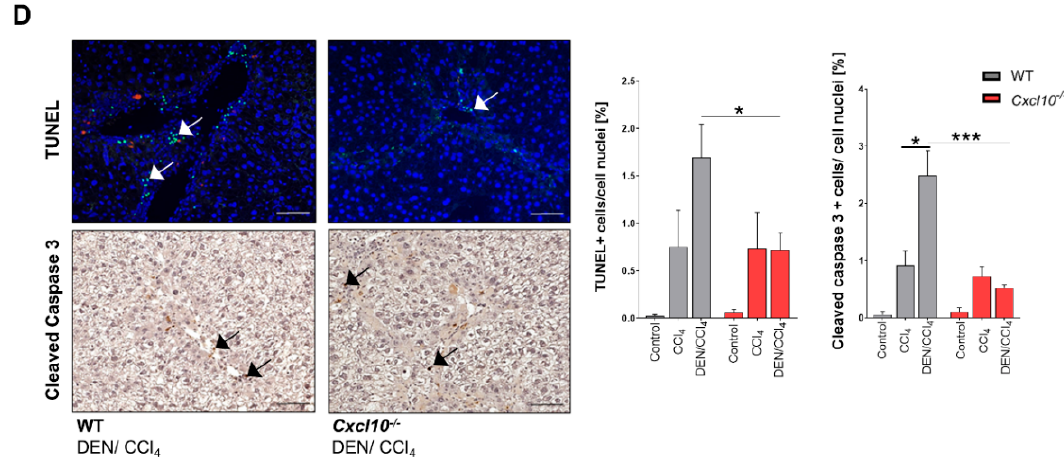
Figure 3. CXCL10 has a direct impact on the tumor-associated angiogenesis and alters the survival of small mononuclear infiltrating cells: ( A ) representative KDR/VEGF-R2 staining (red) of 26 wk old DEN/CCl 4 -treated WT and Cxcl10 − / − mice (scale bar 100 µ m); nuclei were stained with DAPI (blue); white circle: tumor; area fraction and microvessel density (microvessel/tumor); ( B ) human hepatic endothelial cells (HUVEC) (n = 5) were stimulated with CXCL9 or CXCL10. Additionally, a CXCR3 inhibitor was added. Positive control: 0%, 0.5% and 5% FCS. After stimulation, a BrdU assay was performed. Absorbance at 450 nm = proportional to the proliferation rate; ( C ) cleaved caspase-3 staining of 26 wk old mice, activated caspase-3+ cells (green) per total cell count of tumor cells [%]; representative liver pictures; white cycles: tumor tissue; ( D ) TUNEL assay and cleaved caspase-3 staining of 26 wk old mice, TUNEL+/activated caspase-3+ cells per total cell count of infiltrating, mononuclear cells [%]. Three view fields were counted per sample; representative liver pictures (scale bar 200 µ m); arrows: TUNEL+ or cleaved caspase-3+ cells. Data are expressed as mean ± SEM. Asterisks indicate statistical significance: * p < 0.05, ** p < 0.01, *** p < 0.001.